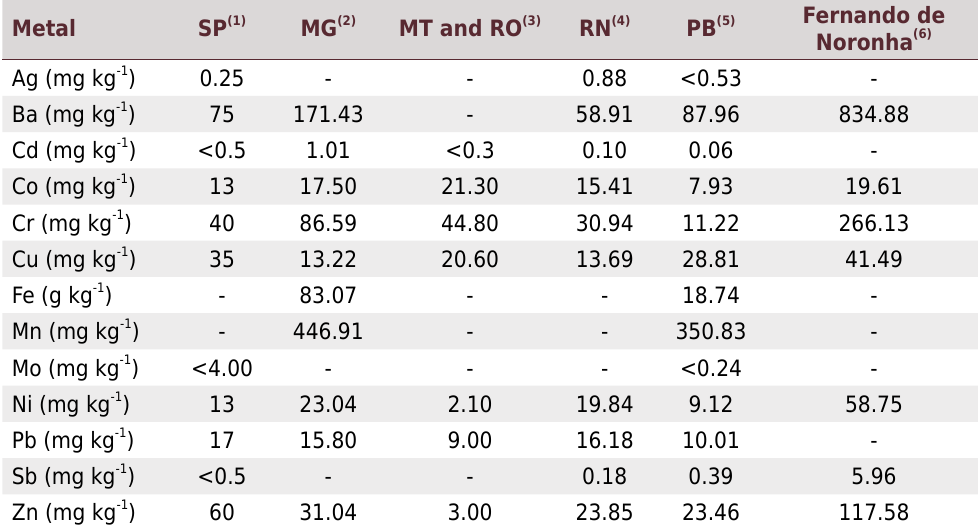
Table 5. Quality reference values (QRVs) for heavy metals in soils of Brazilian states and the archipelago of Fernando de Noronha calculated from the 75 th percentile